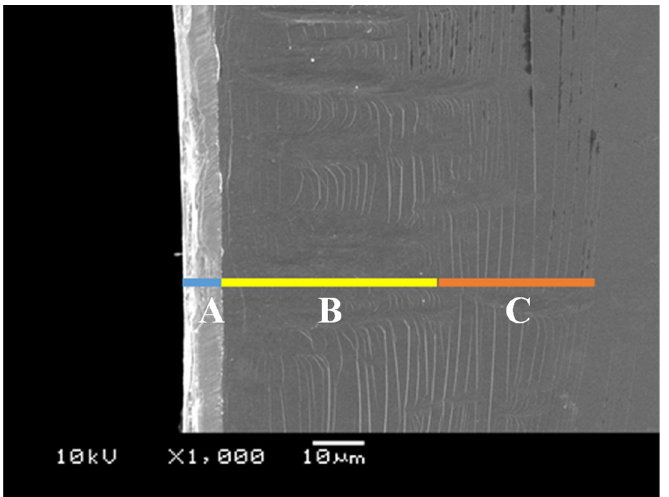
Figure 4. Macroscopic piercing behavior to punch out five electrical amorphous steel sheets in a stacked work by a single shot.